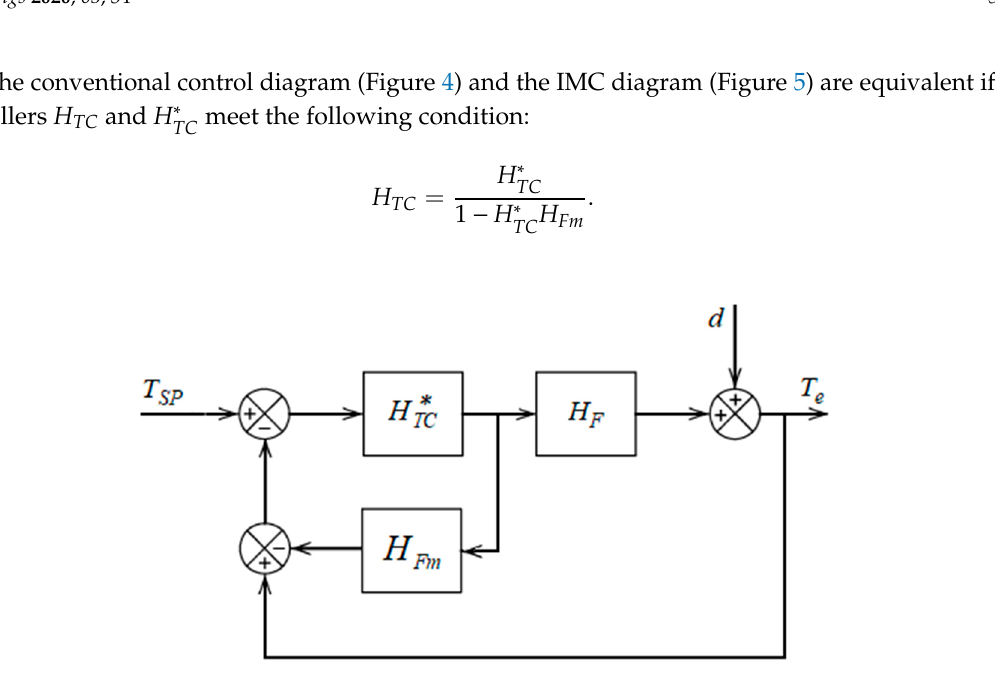
Figure 5. The internal model control (IMC) control block diagram.